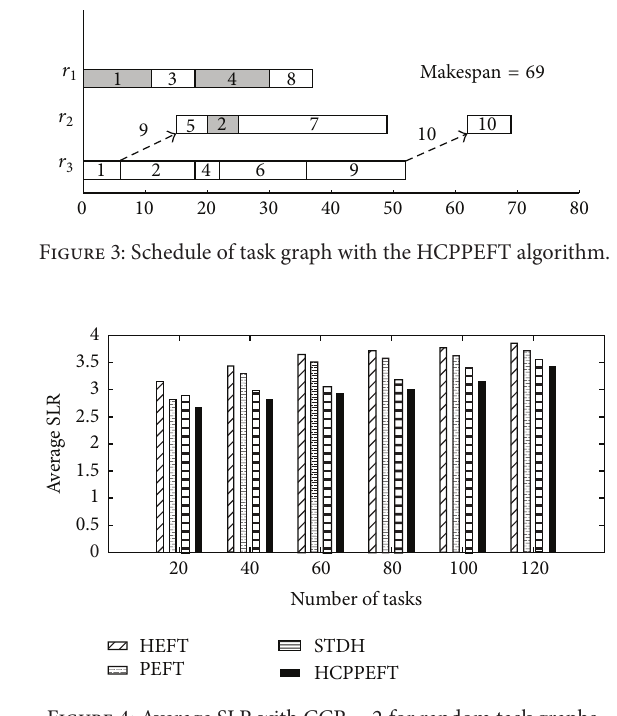
𝑂(𝑛 2 ⋅𝑚) . The HEFT algorithm has a 𝑂(𝑛 2 ⋅𝑚) complexity for 𝑛 tasks and 𝑚 resources. The HCPPEFT algorithm requires the construing task scheduling queue is 𝑂(𝑛 2 ⋅ 𝑚) , and the time complexity of resource select phase is 𝑂(𝑚(𝑛 2 + 𝑛)) . That is, the HCPPEFT algorithm has the same time complexity as the STDH, PEFT, and HEFT